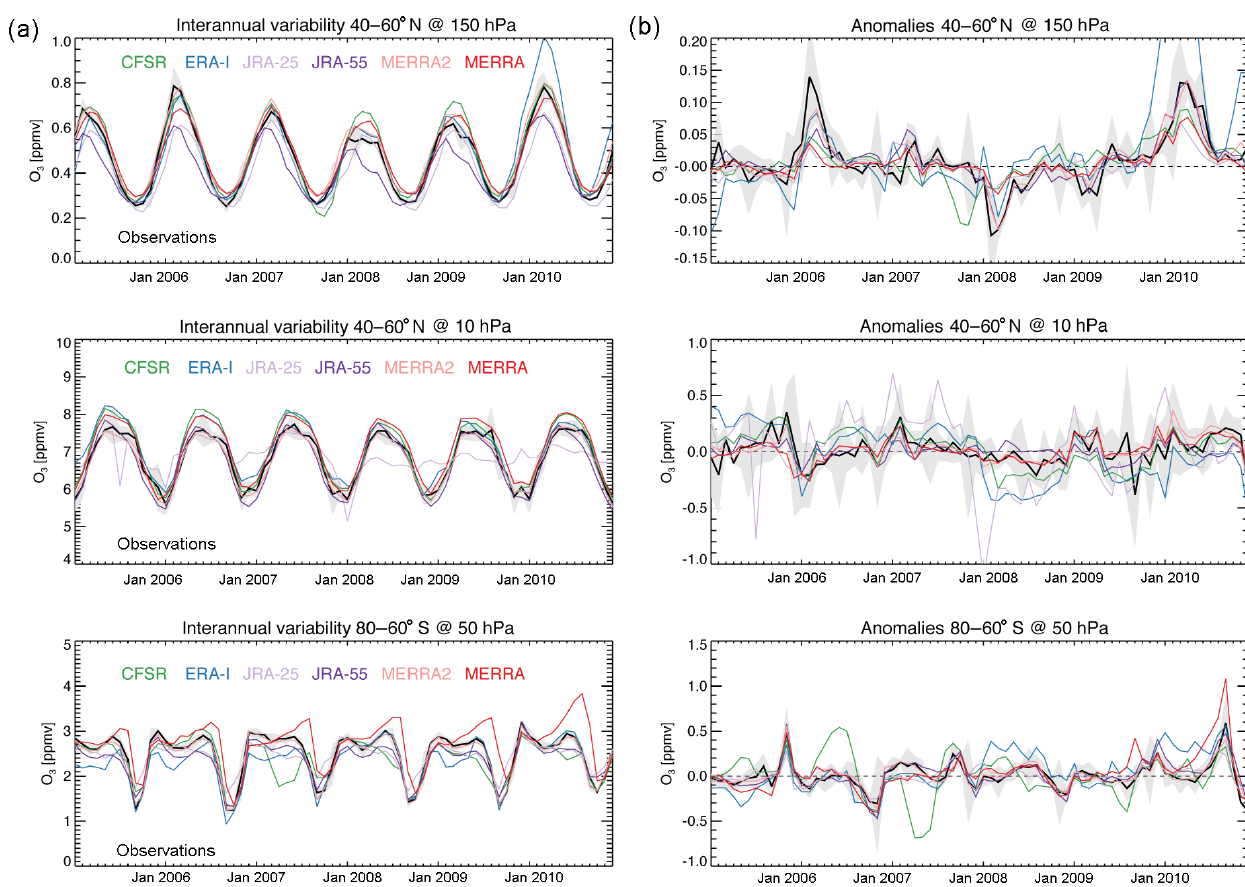
Figure 6. Interannual variability (a) and deseasonalized anomalies (b) for ozone during 2005–2010 for the SPARC Data Initiative multi- instrument mean (SDI MIM, black) and the six reanalyses (colored). Results are shown for three different pressure levels and latitude ranges (top to bottom: 50hPa at 60–80 ◦ S, 10hPa at 20 ◦ S–20 ◦ N, and 100hPa at 40–60 ◦ N). Grey shading indicates observational uncertainty ( ± 1 σ ) calculated as the SD over all instruments and years